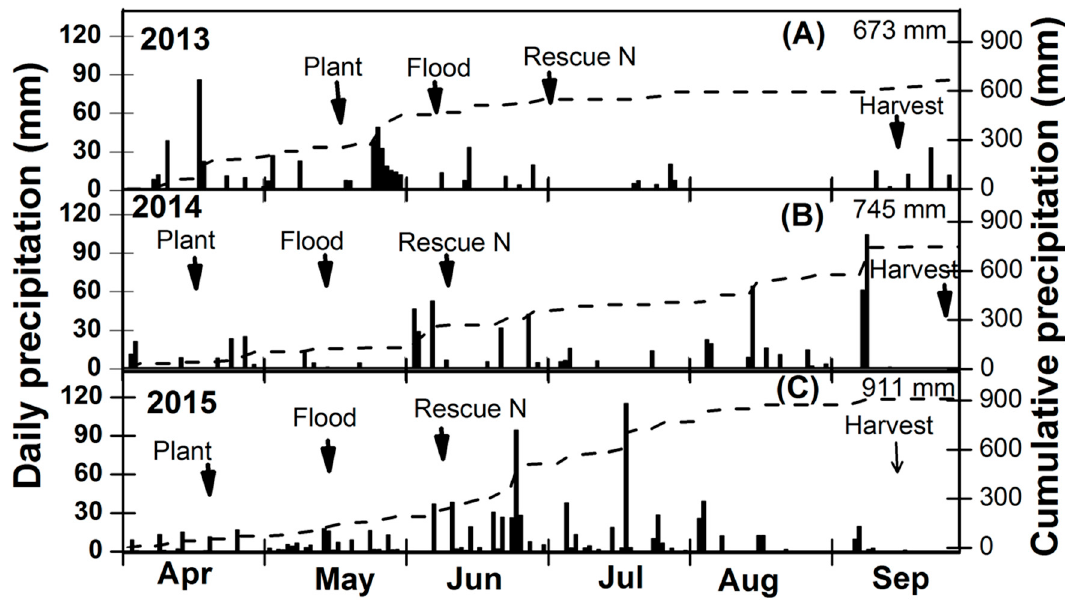
Figure 1. Daily (bars) and cumulative (line) precipitation during the 2013 ( A ), 2014 ( B ) and 2015 ( C ) growing seasons. Arrows represent the timings of major field events. (Source: Kaur, Nelson and Motavalli [29]).